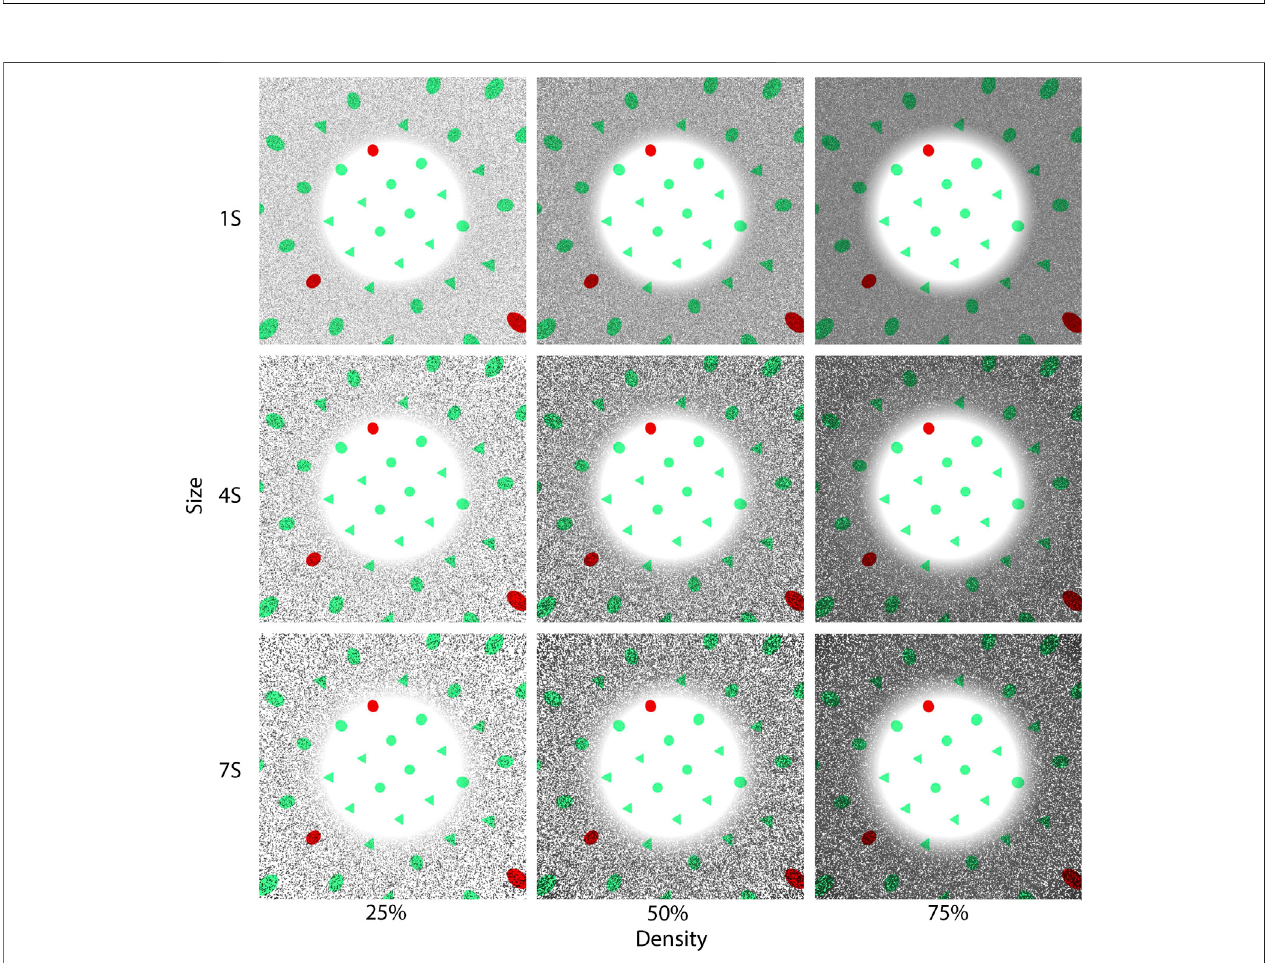
Frontiers in Virtual Reality |